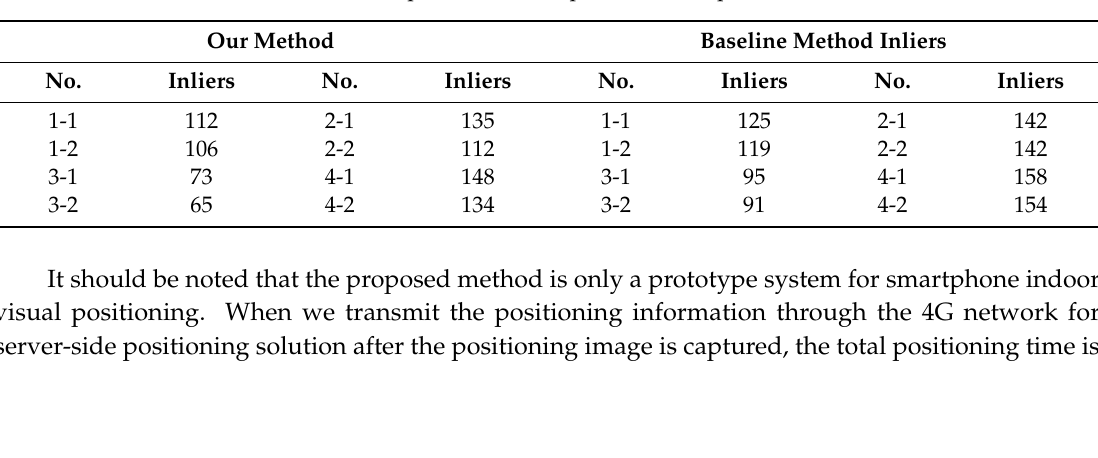
Table 9. Inliers comparison of smartphone camera-pose